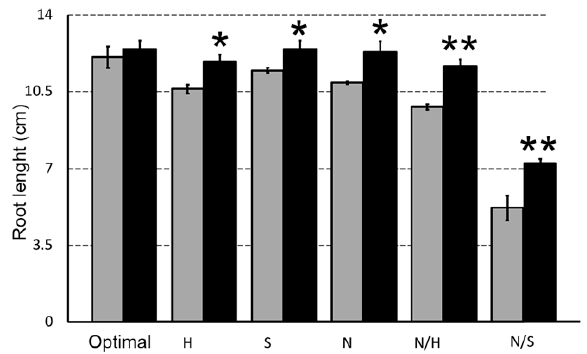
Figure 2. APR® counteracts the negative effects of single and combined abiotic stress on root length. Maize seedlings were subjected for 3 days to several abiotic stresses in absence (grey bars) or in presence (black bars) of 5% APR®. The applied single stresses were: hypoxic stress (H), salt stress (S), nutritional stress (N). The single stresses were combined as: hypoxic stress plus nutritional stress (N/H) and salt stress plus nutritional stress (N/S). The values of root length (cm) are represented in the graphs (mean ± SE) and were calculated from three independent experiments ( n = 10). Significantly different values are evidenced by * (*: p < 0.05; **: p < 0.02; One-way ANOVA, Tukey’s HSD test).